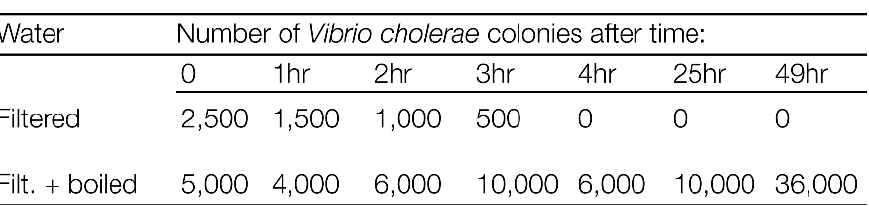
Figure 1. Effect of water from the Junma river on Vibrio cholerae bacteria (data from [15]). It is debated if the antibacterial effect was due to phages or other agents present in the river water [16].